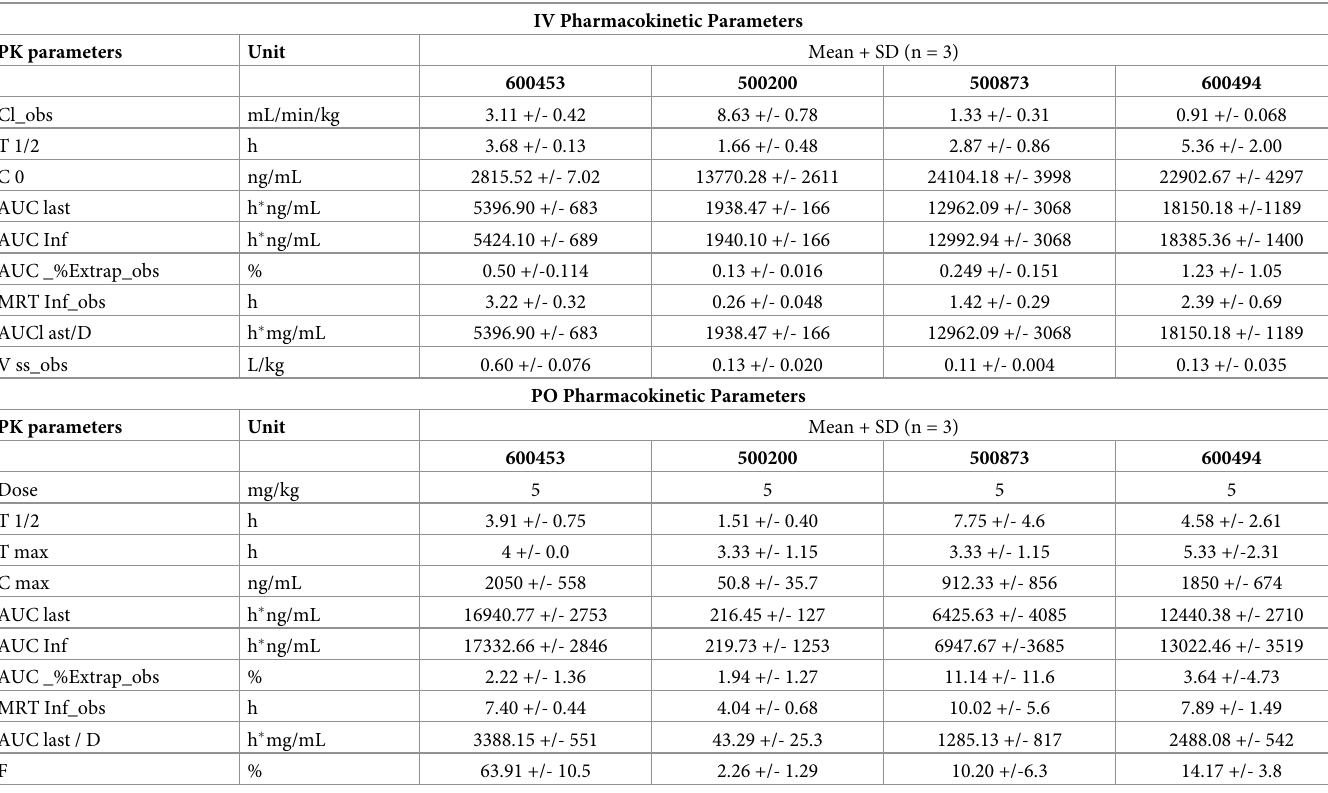
Table 2. Pharmacokinetic parameters for phenylbenzamides after 1 mg/kg intravenous injection or 5mg/kg oral dose in Sprague Dawley